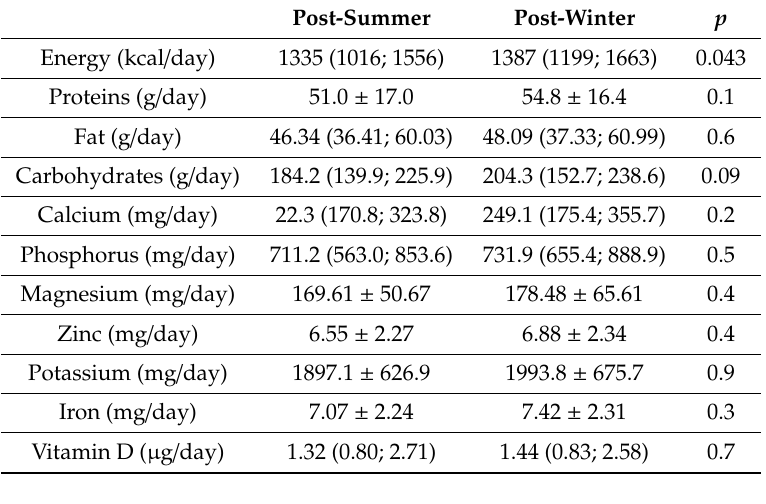
Table 3. Dietary intake of selected nutrients in the post-summer and post-winter period. Data are shown as mean ± standard deviation or median (lower; upper quartiles).